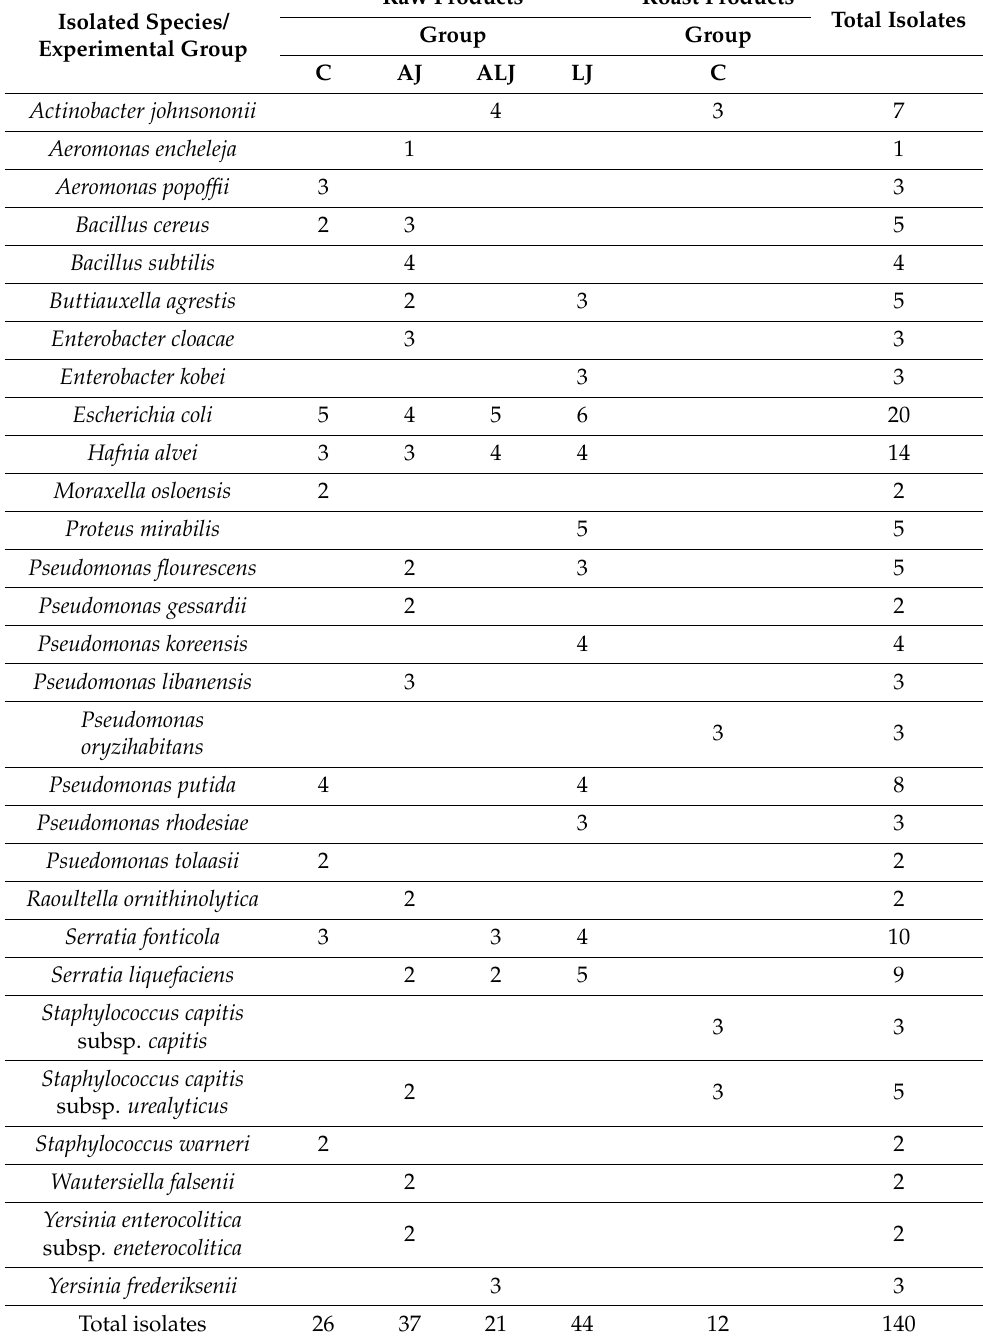
Table 4. Isolated bacteria from marinated raw and roasted